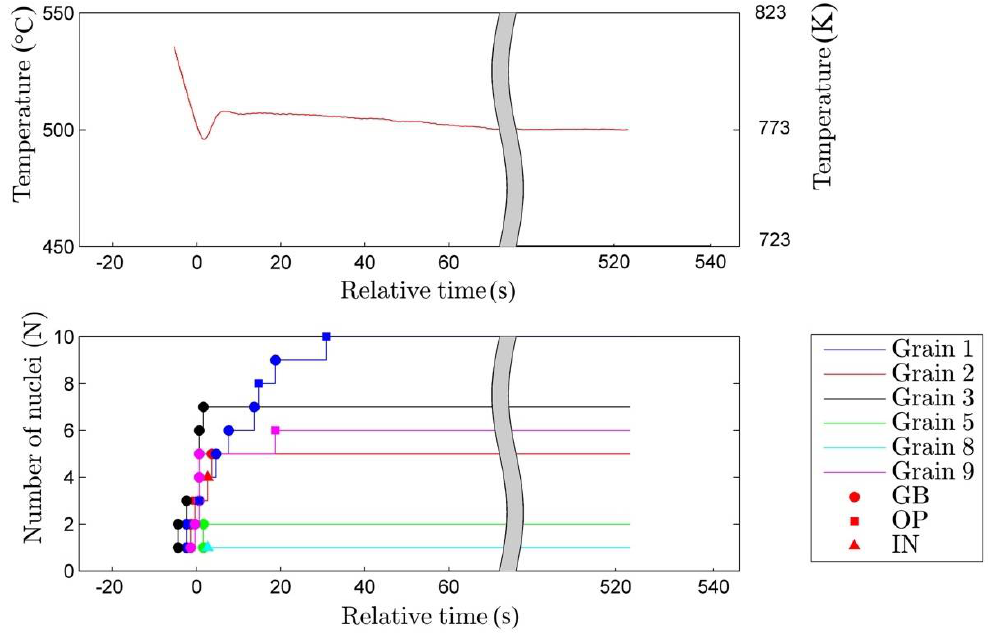
Figure 4. Temperature and nucleation sequence versus time of bainitic ferrite plates in Fe-0.2C-1.5Mn- 2.0Cr during isothermal holding treatment at 773 K (500 °C).